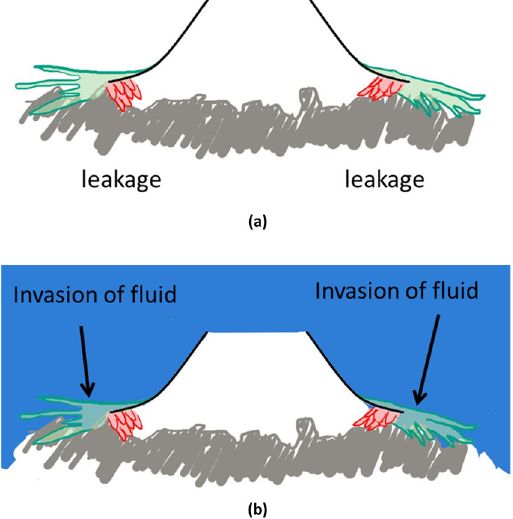
Figure 5. Illustrations showing the functions of inward setae (red) and outer fibers (green). ( a ) Inward setae can help attach to the rough surfaces and compensate the leakages. ( b ) Outer fiber can prevent the invasion of